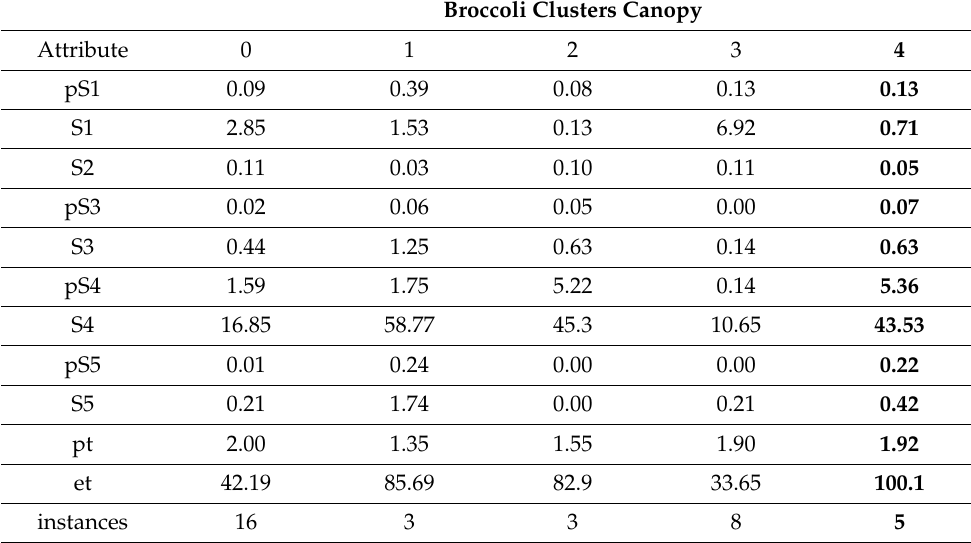
Table 7. Canopy clusterization of broccoli production.